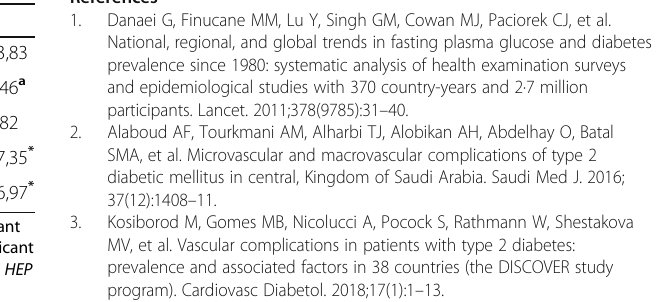
Table 10 Effect of peel extracts of I. wombolu on the liver and heart catalase activity (U/mg of proteins) Groups